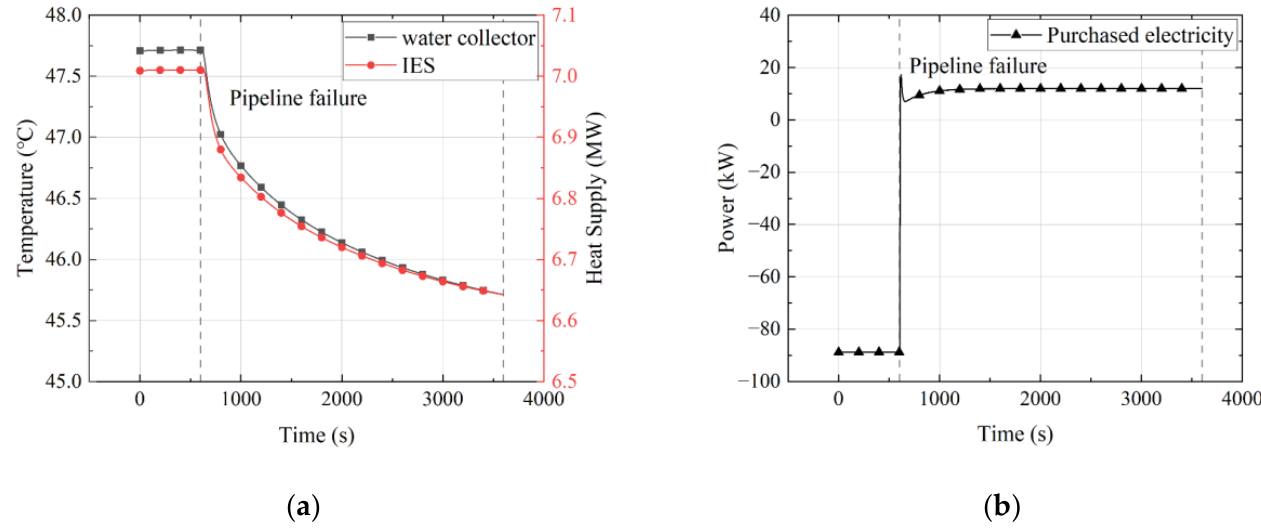
Figure 9. Response of the IES during pipeline failure period. ( a ) heat subnet; ( b ) power subnet.